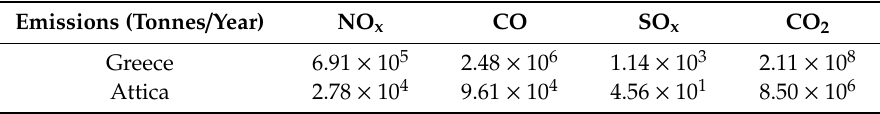
Table 1. Estimated road transport emissions for Greece and Attica, 2016 [44].